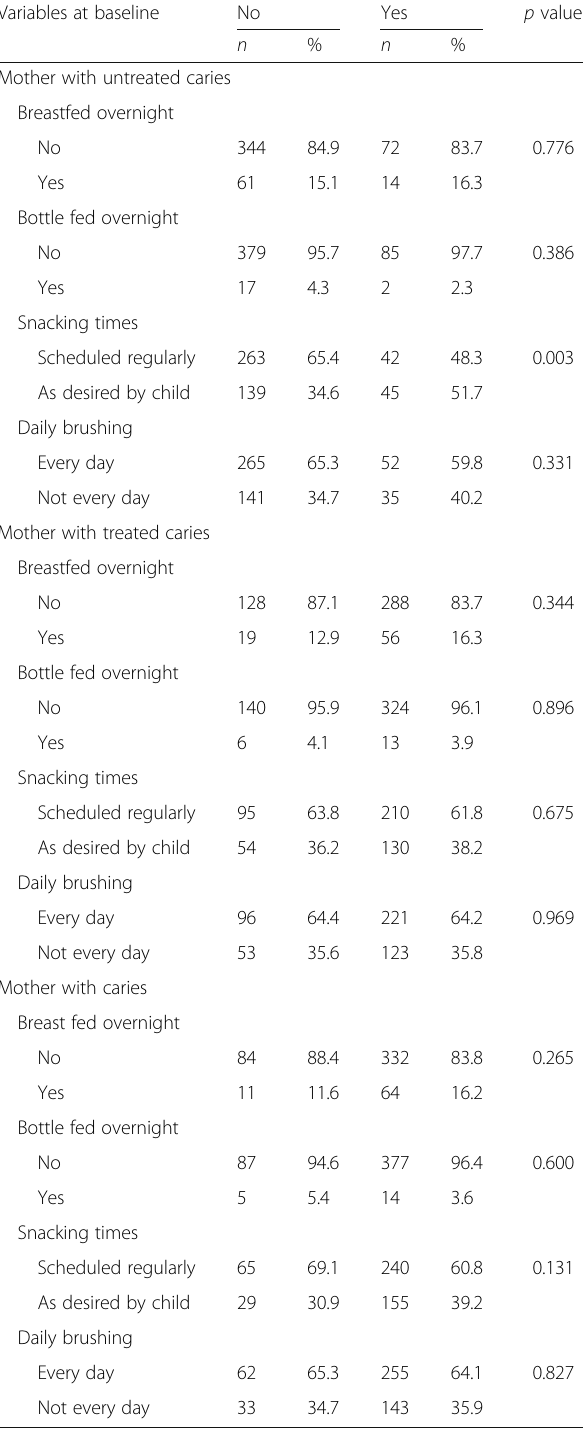
Table 6 Child ’ s health habits associated with mother ’ s dental health